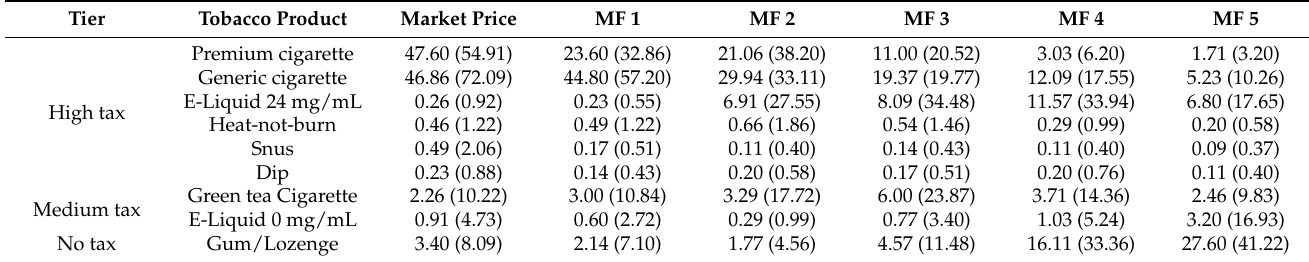
Table A2. Group mean and standard deviation of purchased tobacco products across trials in the tobacco parity tax proposal. Tier